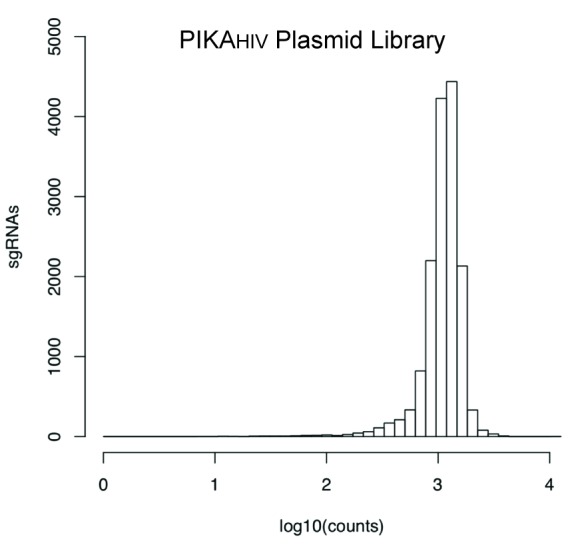
sgRNA read counts for the sequenced PIKAHIV Plasmid Library.Individual 20bp sgRNA sequences were binned and the distribution of read counts is displayed along the X-Axis.